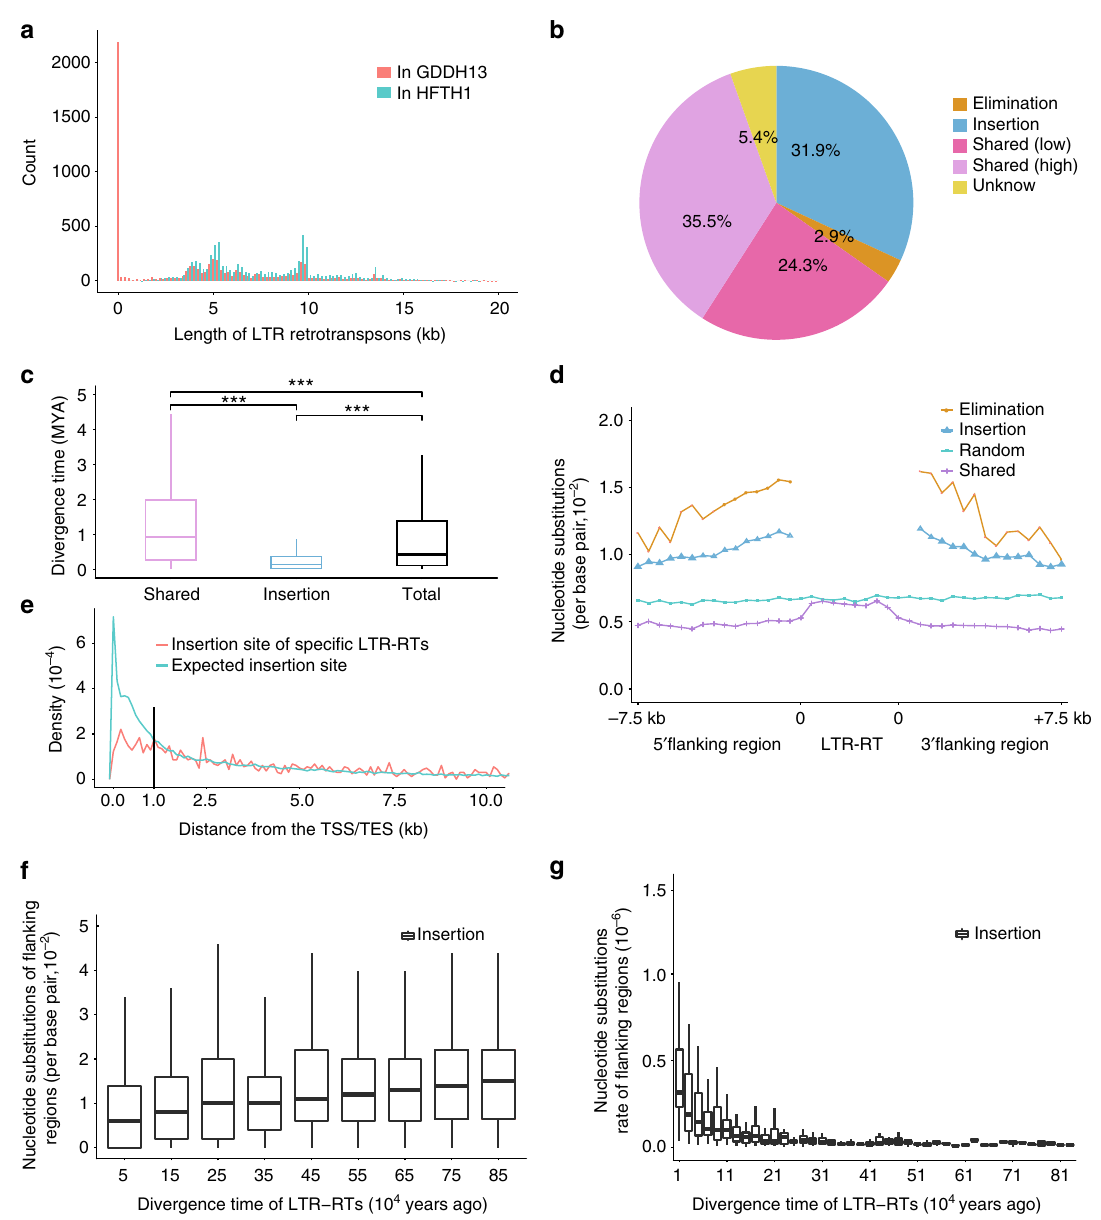
Fig. 3 Evolution of intact LTR retrotransposons in the HFTH1 genome. a Length distribution of intact LTR-RTs from the HFTH1 genome. A large number of LTR-RTs in the GDDH13 genome have a length <100 bp, which indicated that these LTR-RTs were newly inserted into the HFTH1 genome or eliminated from the GDDH13 genome. b Pie chart showing the classi fi cation of the LTR-RTs in the HFTH1 genome (see Methods for the de fi nition of each type). c Estimated divergence time of each category of LTR-RTs in the HFTH1 genome. The divergence time was calculated using a substitution rate of 1.3 × 10 − 8 substitutions per site per year. Wilcoxon rank sum test, *** p < 0.001 and n = 3468, 1850, 5800 for Shared, Insertion, Total, respectively. d Distribution of cumulative nucleotide substitutions of LTR-RTs and fl anking sequences. The nucleotide substitutions of both fl anking regions were calculated in a 400 bp sliding window, and the nucleotide substitutions of LTR-RT inside regions were calculated in ten non-overlapping equal bins. Three thousand blocks in the HFTH1 genome with a length 20 kb were randomly selected and used as a control. e Distribution of insert sites of speci fi c LTR-RTs in the GDDH13 genome in 100-bp windows located at an increasing distance from genes. The distribution of intergenic distance was used as a control. f Distribution of cumulative nucleotide substitutions of fl anking sequences over the divergence time of LTR-RTs. The fl anking sequences were de fi ned as 500 bp fragments located the upstream and downstream of LTR-RTs. The cumulative nucleotide substitutions were calculated in a sliding window of 100,000 years. g Rate of cumulative nucleotide substitutions of fl anking sequences relative to the divergence time of LTR-RTs (see Methods for details). The middle hinge of all boxes is the median, the lower and upper hinges correspond to the 25th and 75th percentiles, and the whiskers represent the 1.5 inter-quartile range (IQR) extending from the hinges. Source data of Fig. 3a, b, c and e are provided in Source Data fi le 1. Source data of Fig. 3d, f and g are provided in Source Data fi le